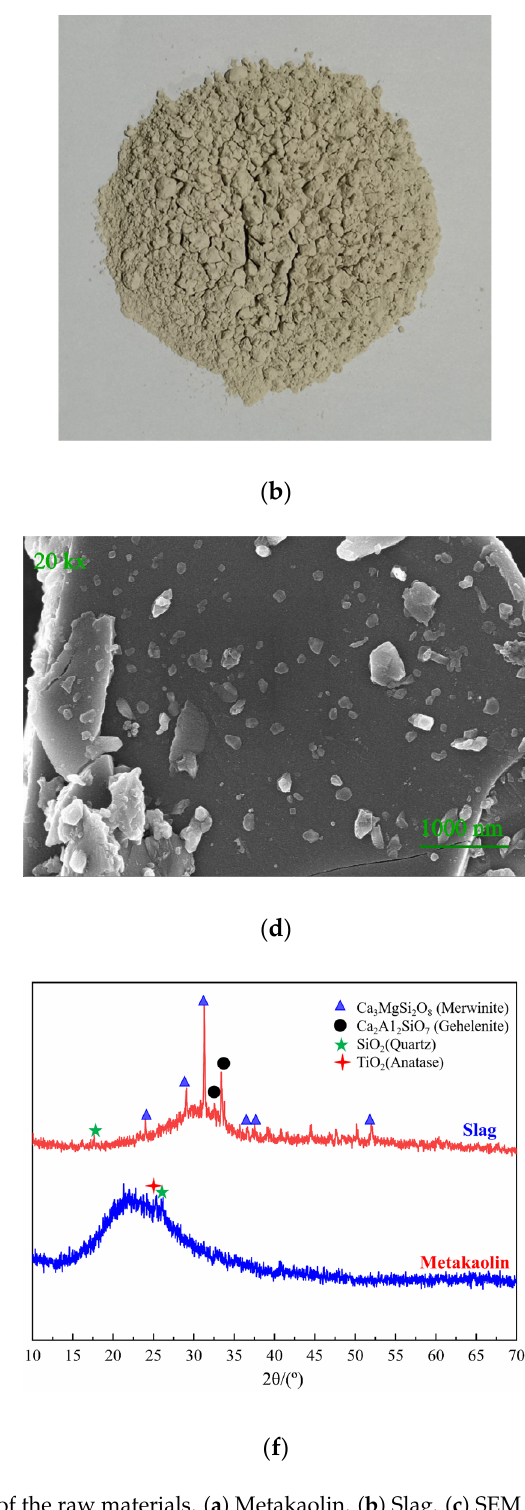
Figure 1. Physicochemical properties of the raw materials. ( a ) Metakaolin. ( b ) Slag. ( c ) SEM image of metakaolin. ( d ) SEM image of slag. ( e ) Particle size distributions of slag and metakaolin. ( f ) XRD results for slag and